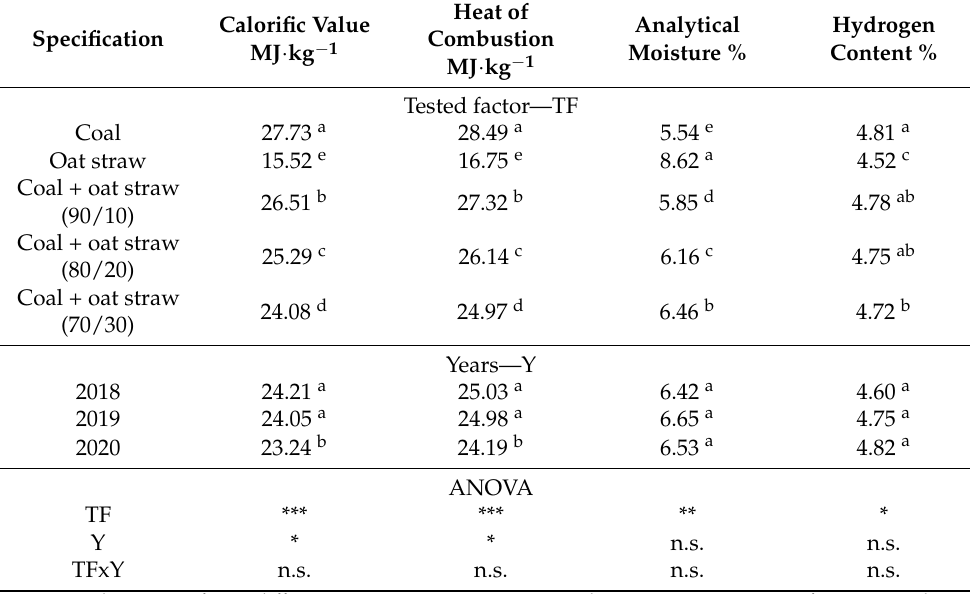
Table 2. Energy parameters of individual raw materials.